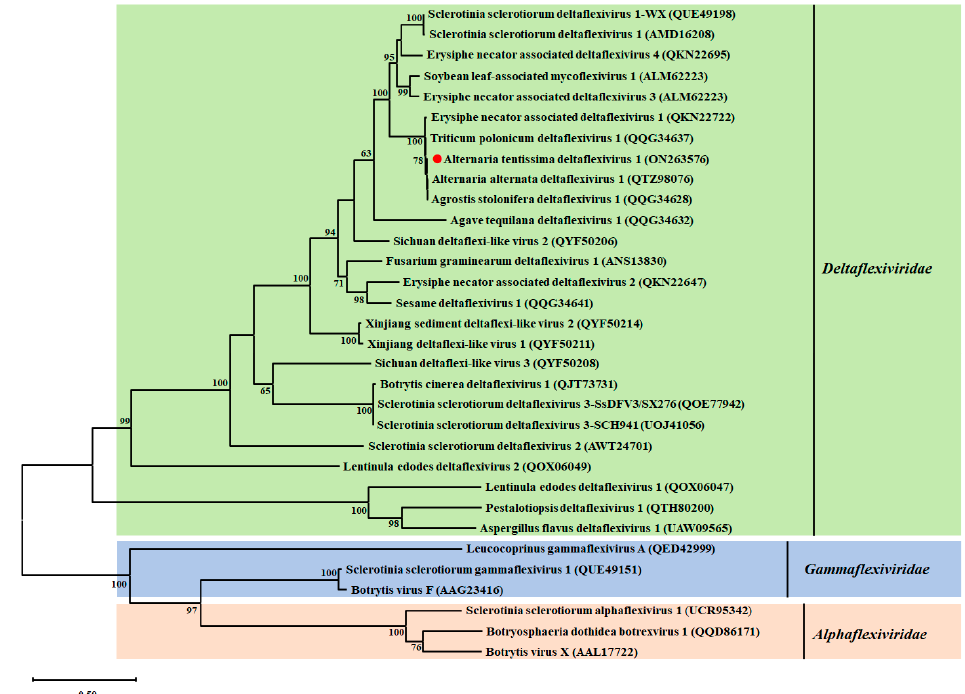
Figure 4. Phylogenetic analysis of AtDFV1 and other selected viruses using the maximum likelihood method with 1000 bootstrap replications. Comparisons of conserved the entire replication-associated polyprotein among members of several genera of the families Alpha -, Gamma -, and Deltaflexiviridae . Numbers on the left of branches indicate the data coverage percentage, and a red circle ( • ) indicates the position of virus AtDFV1. We used a best-fit model of protein evolution (LG+G+I) to construct the phylogenetic tree and set the gamma value to